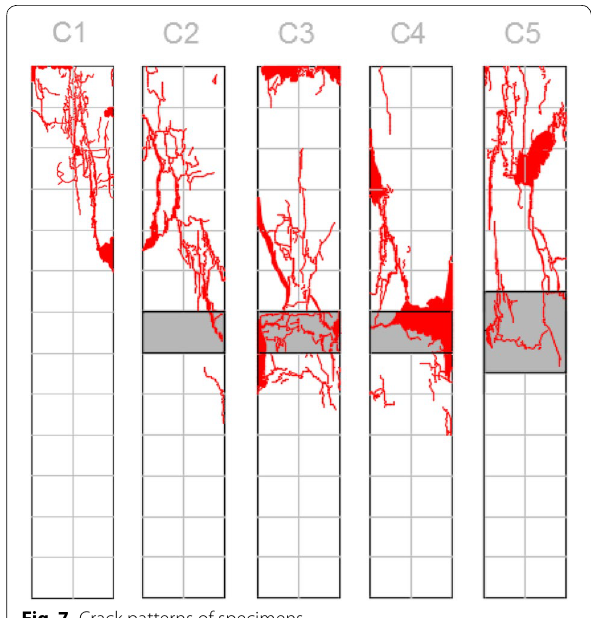
Fig. 7 Crack patterns of